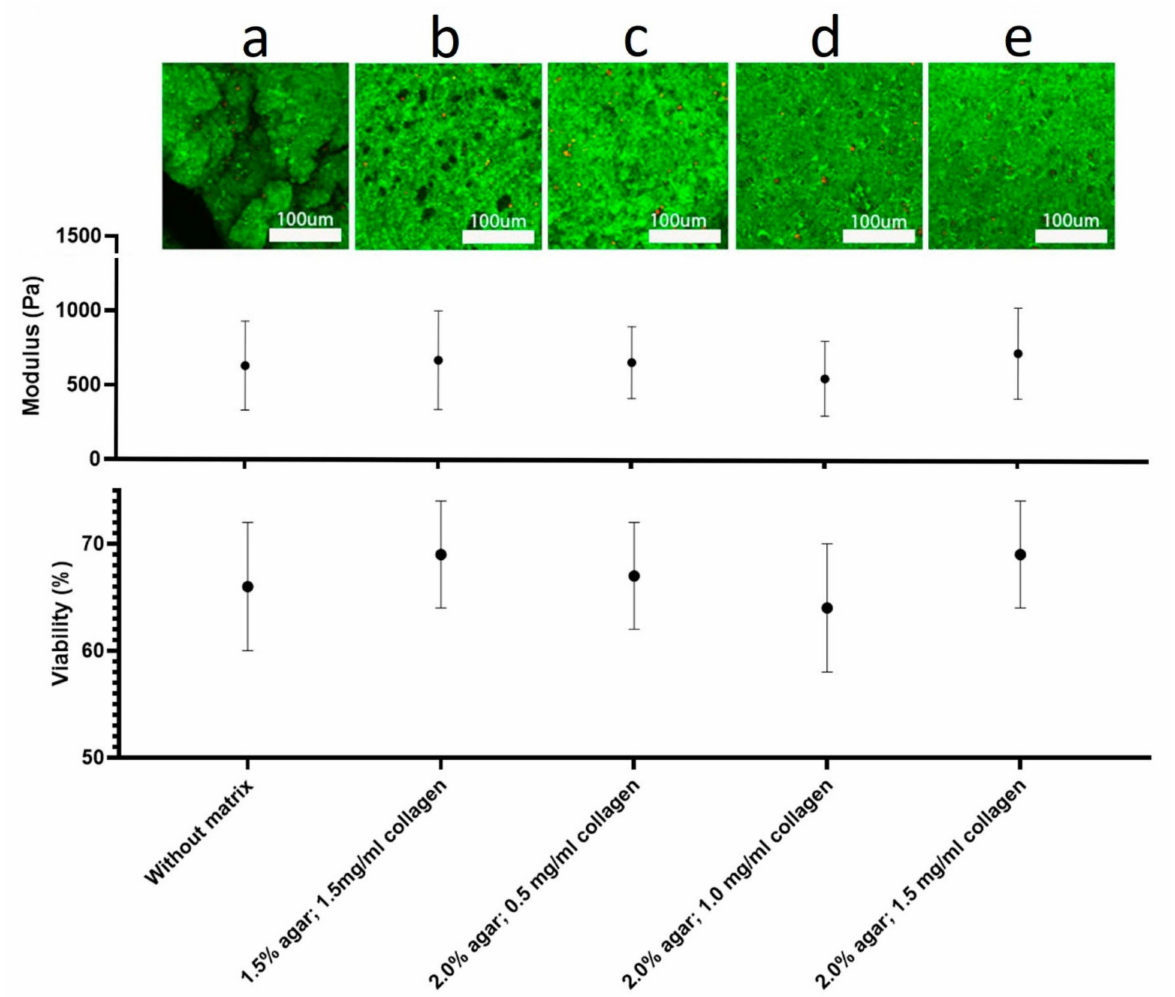
Figure 1. Comparative characteristics of the mechanics and viability of tissue sections obtained in different types of embedding matrix with tissue not subjected to vibratomy. ( a ) A tissue fragment not subjected to vibratomy in the matrix. ( b ) Tissue section obtained in a matrix consisting of 1.5% agar, 1.5 mg/mL collagen. ( c ) Tissue section obtained in a matrix consisting of 2.0% agar, 0.5 mg/mL collagen. ( d ) Tissue section obtained in a matrix consisting of 2.0% agar, 1.0 mg/mL collagen. ( e ) Tissue section obtained in a matrix consisting of 2.0% agar, 1.5 mg/mL